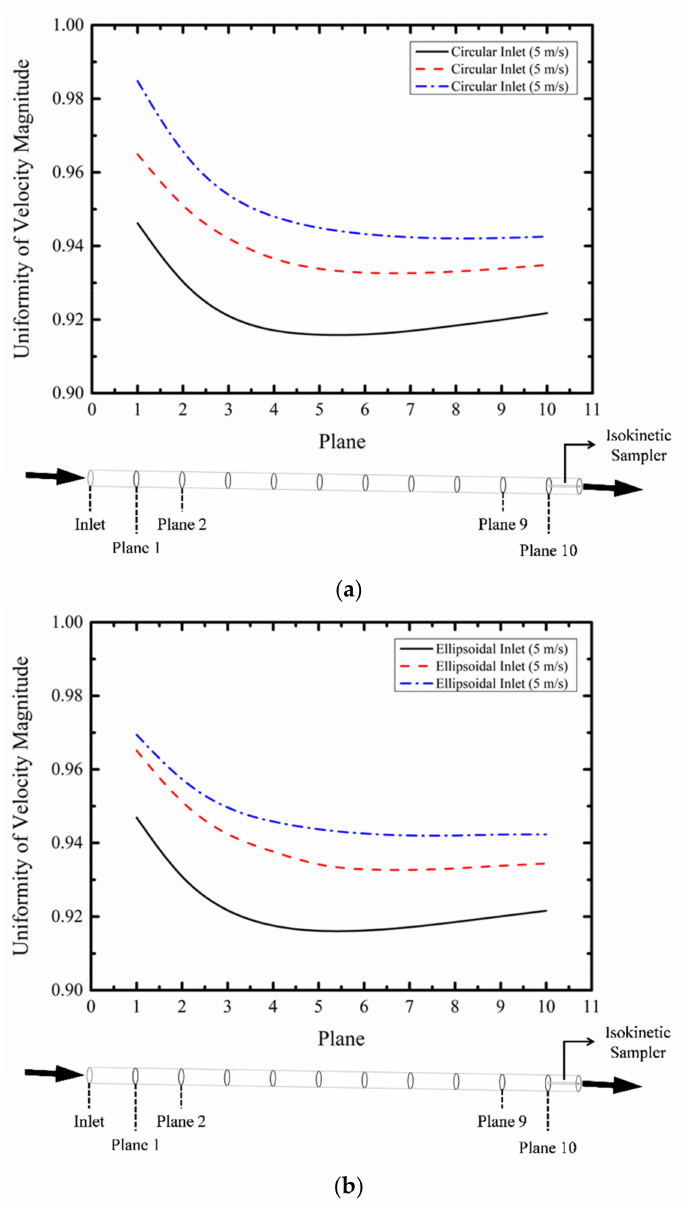
Figure 5. Uniformity of free-stream velocity: ( a ) circular inlet; and ( b ) ellipsoidal